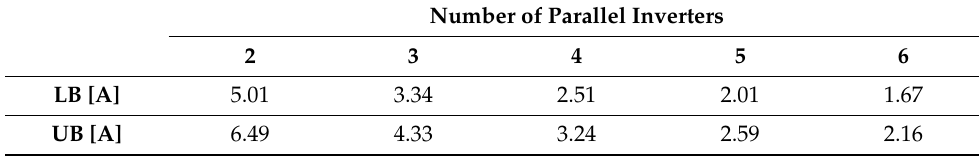
Table 1. Comparator